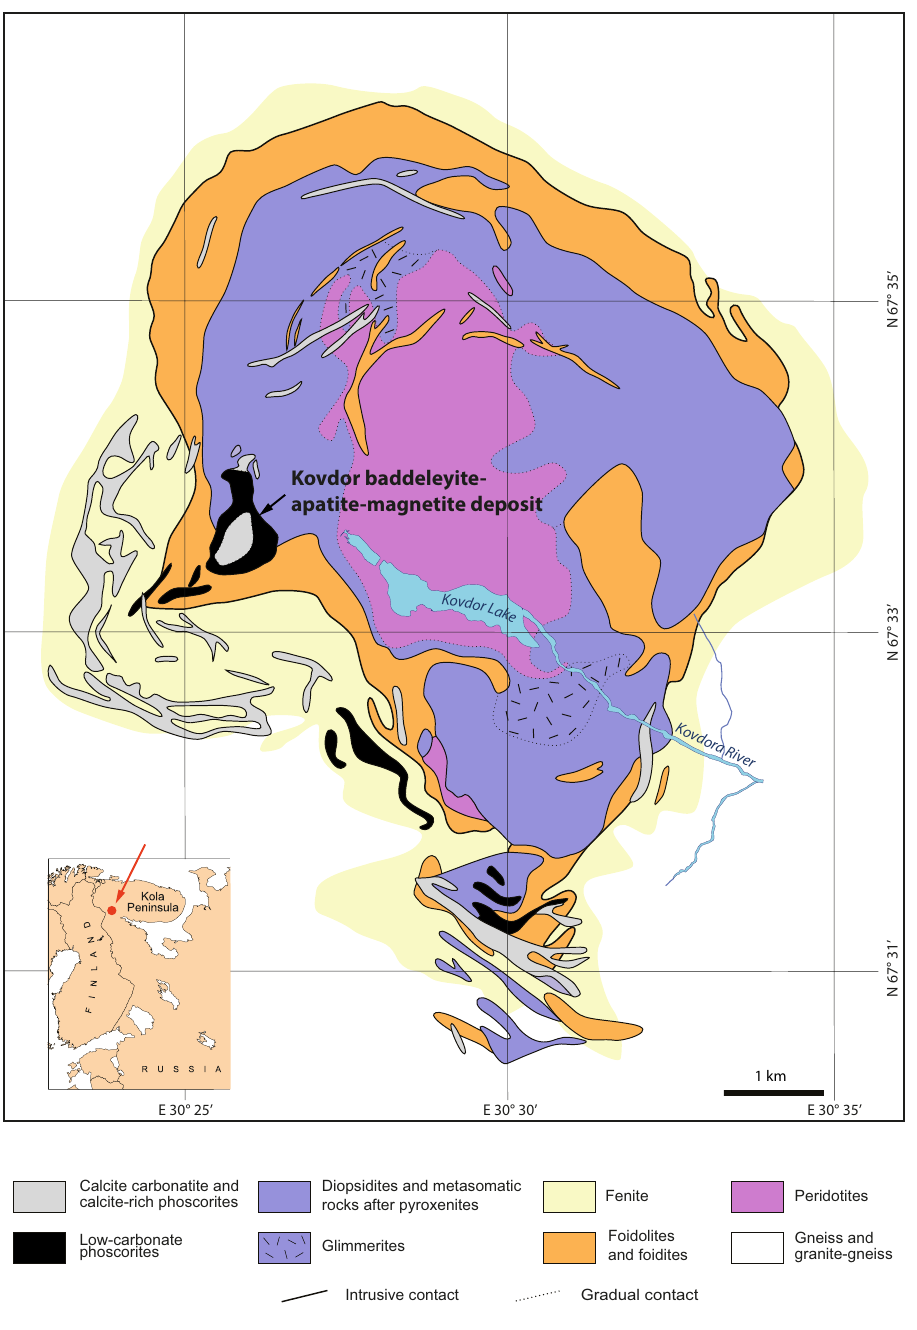
Figure 1. Geological map of the Kovdor massif (modified from ref.